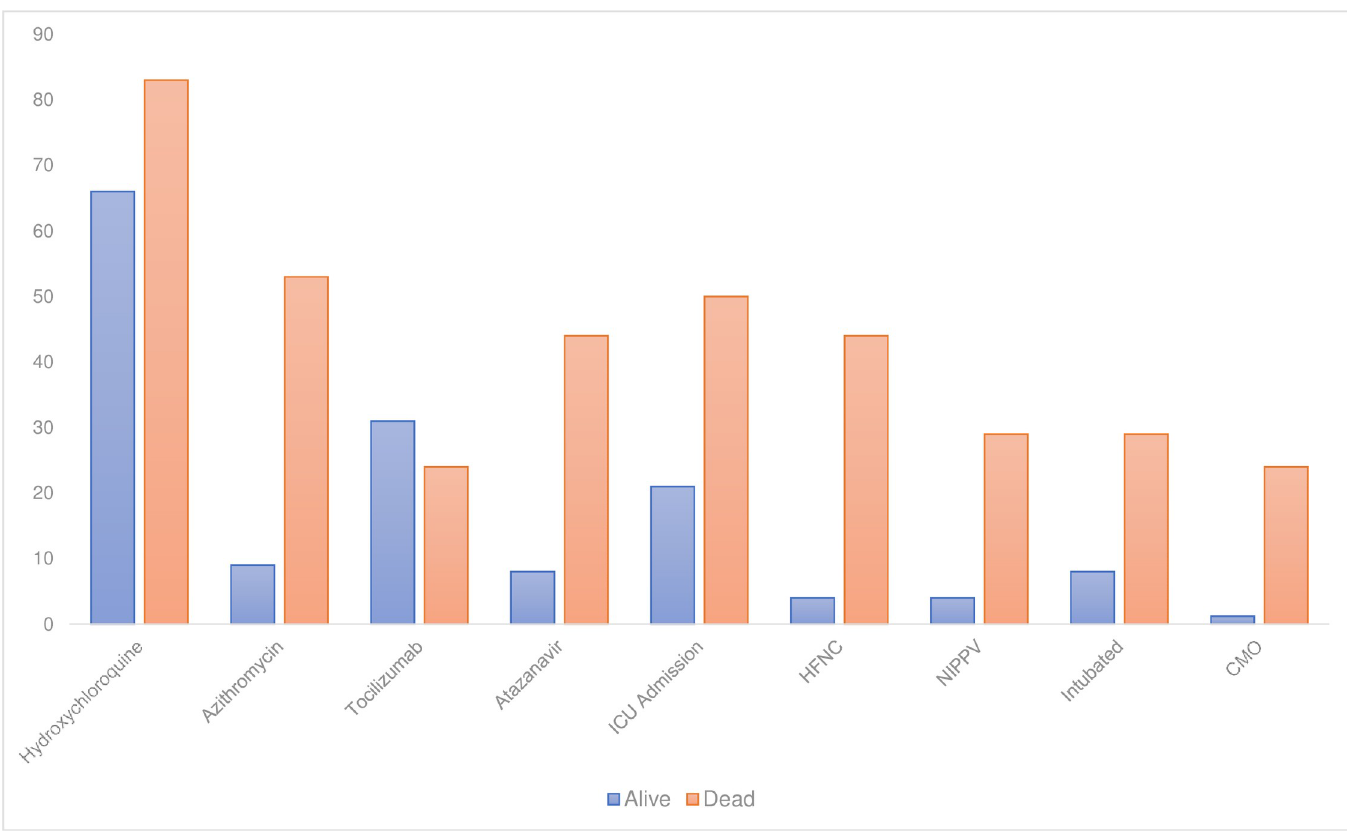
Fig 3. Medical and supportive interventions in COVID-19+ patients according to clinical outcome. ICU = Intensive Care Unit; HFNC = High flow nasal canula; NIPPV = Non-invasive positive pressure ventilation; CMO = comfort measures only.